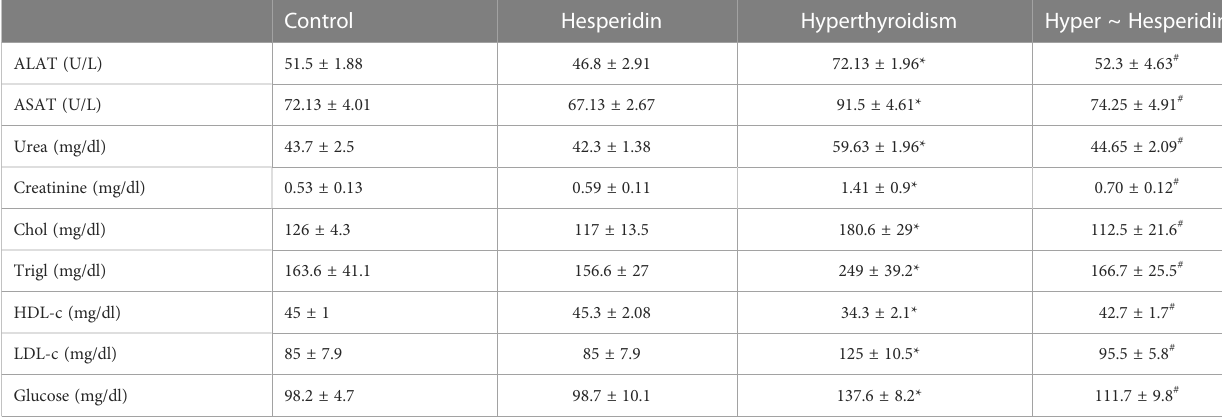
TABLE 4 Activities of serum ASAT and ALAT, and levels of serum urea, creatinine and glucose of healthy and hyperthyroidism-treated animals ’ groups as compared to control